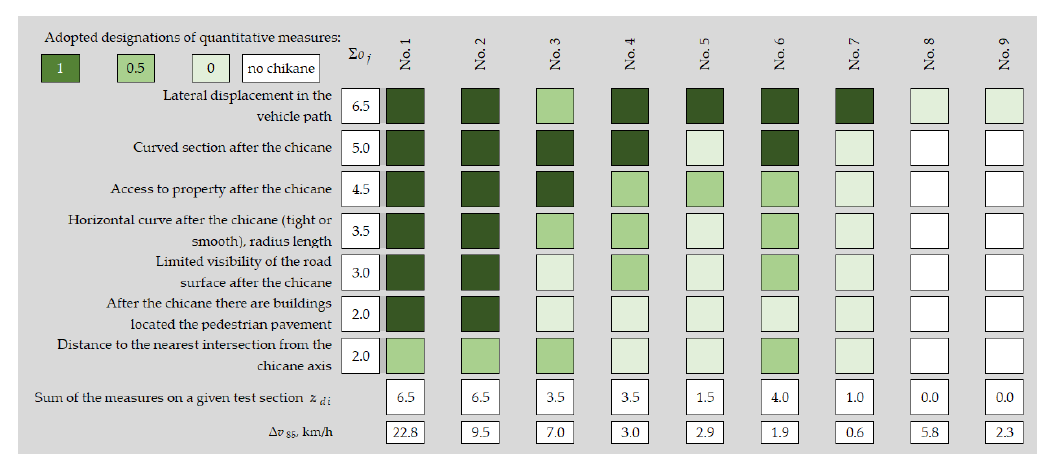
Figure 15. Outcomes of the assessment of the factors associated with the road design parameters criterion. Designations: o j —a subsequent factor in consideration, Σ oj —sum of confirmed logical